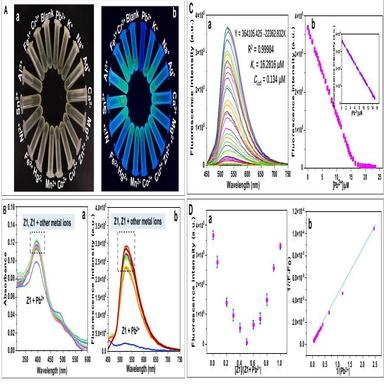
Images show the selective behavior of the probe Z1 for Pb2+. A. (a) Color changes of different metal ions (K+, Pb2+, Ca2+, Na+, Mg2+, Zn2+, Fe2+, Cu2+, Ni+, Hg2+, Cd2+, Al3+, Fe3+, Co2+, Cr3+, Ag+ and Ni2+) added to Z1 solution under sunlight. (b) Fluorescence color changes of different metal ions (K+, Pb2+, Ca2+, Na+, Mg2+, Zn2+, Fe2+, Cu2+, Ni+, Hg2+, Cd2+, Al3+, Fe3+, Co2+, Cr3+, Ag+ and Ni2+) added to probe Z1 solution under Uv-vis lamp (365 nm). B. (a) Uv-vis absorption spectra of different metal ions